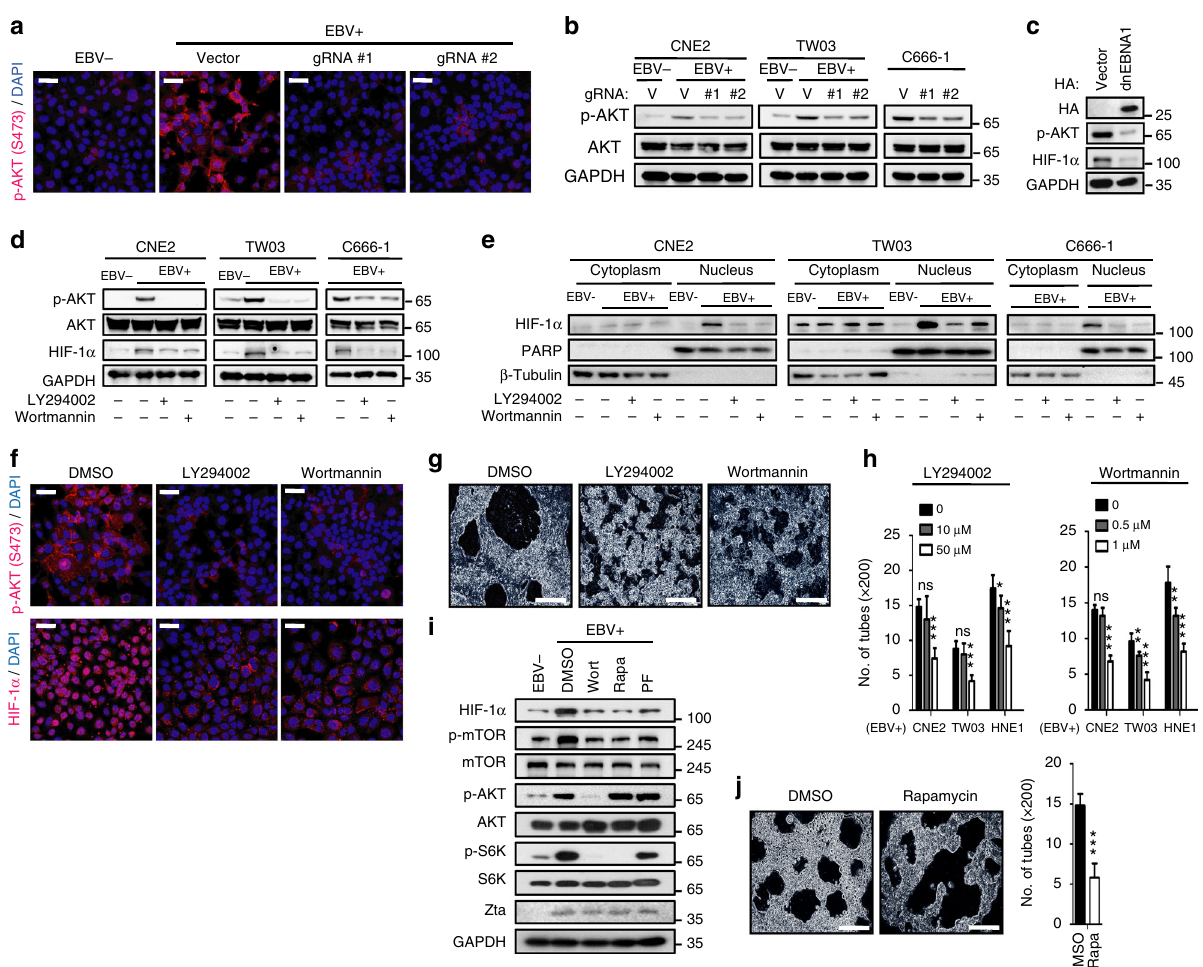
Fig. 5 EBV promotes VM formation via the PI3K/AKT/mTOR/HIF-1 α axis. a Immuno fl uorescence of phospho-AKT (S473) in TW03 cells and TW03-EBV cells with or without targeting EBV by CRISPR/Cas9. Scale bars = 50 μ m. b Immunoblots comparing AKT phosphorylation in EBV- and EBV + NPC cell lines. c CNE2-EBV cells were transfected with empty vector or a dominant-negative mutant of EBNA1 (dnEBNA1), followed by WB analysis using antibodies as indicated. d Immunoblots of AKT phosphorylation and HIF-1 α expression following LY294002 (50 μ M) or Wortmannin (1 μ M) treatment for 6 h. e Immunoblots of HIF-1 α distribution in cytoplasmic and nuclear fractions of EBV- and EBV + NPC cells following LY294002 (50 μ M), Wortmannin (1 μ M) or DMSO treatment for 6 h. f Immuno fl uorescence of phospho-AKT (S473) and HIF-1 α in TW03-EBV cells after 6 h of treatment with DMSO, LY294002 (50 μ M) or Wortmannin (1 μ M). Scale bars = 50 μ m. g Microscopy of tube formation on Matrigel in TW03-EBV cells after 12 h of treatment with LY294002 (50 μ M) or Wortmannin (1 μ M). Scale bars = 100 μ m. h Quanti fi cation of tube numbers formed by NPC-EBV cells following LY294002 or Wortmannin treatment. Mean ± SD, n = 5, two-tailed unpaired t -test. i Effects of PI3K/mTOR/S6K kinase inhibitors on EBV-induced HIF-1 α expression. CNE2-EBV cells were treated with DMSO, 1 μ M Wortmannin (Wort), 0.5 μ M rapamycin (Rapa) or 10 μ M PF-4708671 (PF) for 6 h under normoxic conditions prior to immunoblotting with antibodies, as indicated. j Effect of rapamycin (0.5 μ M) on VM channel formation of CNE2-EBV cells. Mean ± SD, n = 5, two-tailed unpaired t -test. ns: not signi fi cant, * p < 0.05, *** p < arrows) were lined with EBER-positive tumor cells and contained GT38 and GT39, demonstrated that EBV-positive gastric red blood cells (Fig. 7a, top panel). Quanti fi cation of IHC staining carcinoma cells formed tubes on 3D Matrigel culture, which results demonstrated that the PAS + CD31 − NPC tumor cells did not occur in the EBV-negative AGS cells (Supplementary expressed high levels of EBER, phospho-AKT, and HIF-1 α Fig. 6b, c). More importantly, histological analysis of human (Fig. 7b). These data con fi rmed the existence of VM in NPC gastric carcinoma tissues suggested that EBVaGC displayed more clinical samples and further demonstrated the association VM structures and expressed higher levels of phospho-AKT and between EBV infection, VM formation, and AKT/HIF-1 α nuclear HIF-1 α than did EBV-negative gastric carcinoma tissue activation. (Fig. 7a, bottom panel and c), indicating that EBV plays a general role in VM formation via the AKT/HIF-1 α axis in EBV- associated epithelial malignancies.